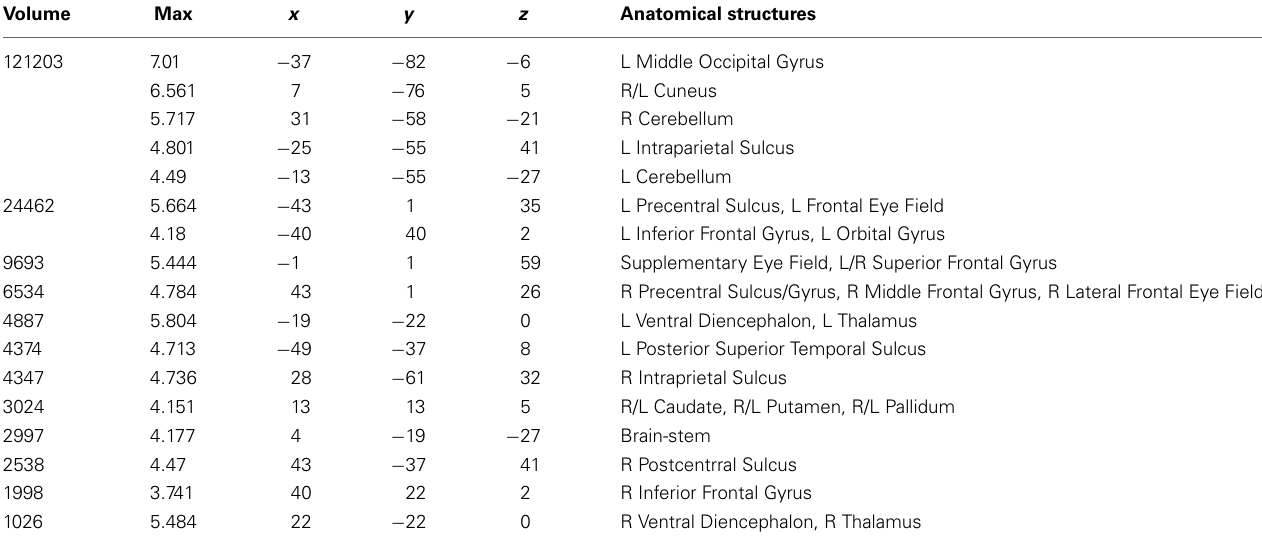
Table 3 | Talairach coordinates, volume of the cluster ( µ l), maximum z-score, and the label of anatomical structure for the pseudoword text (PW) condition > fixation analysis, L, left hemisphere; R, right